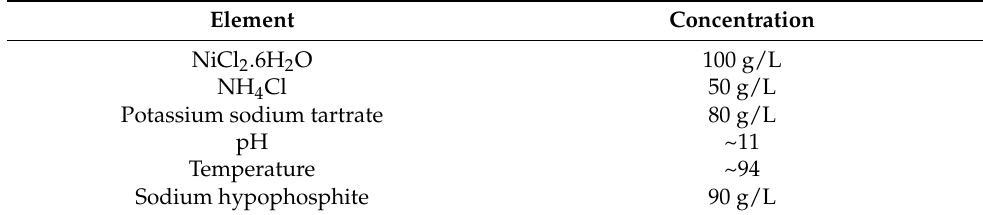
Table 1. Chemical composition of the bath for the electroless nickel plating process.